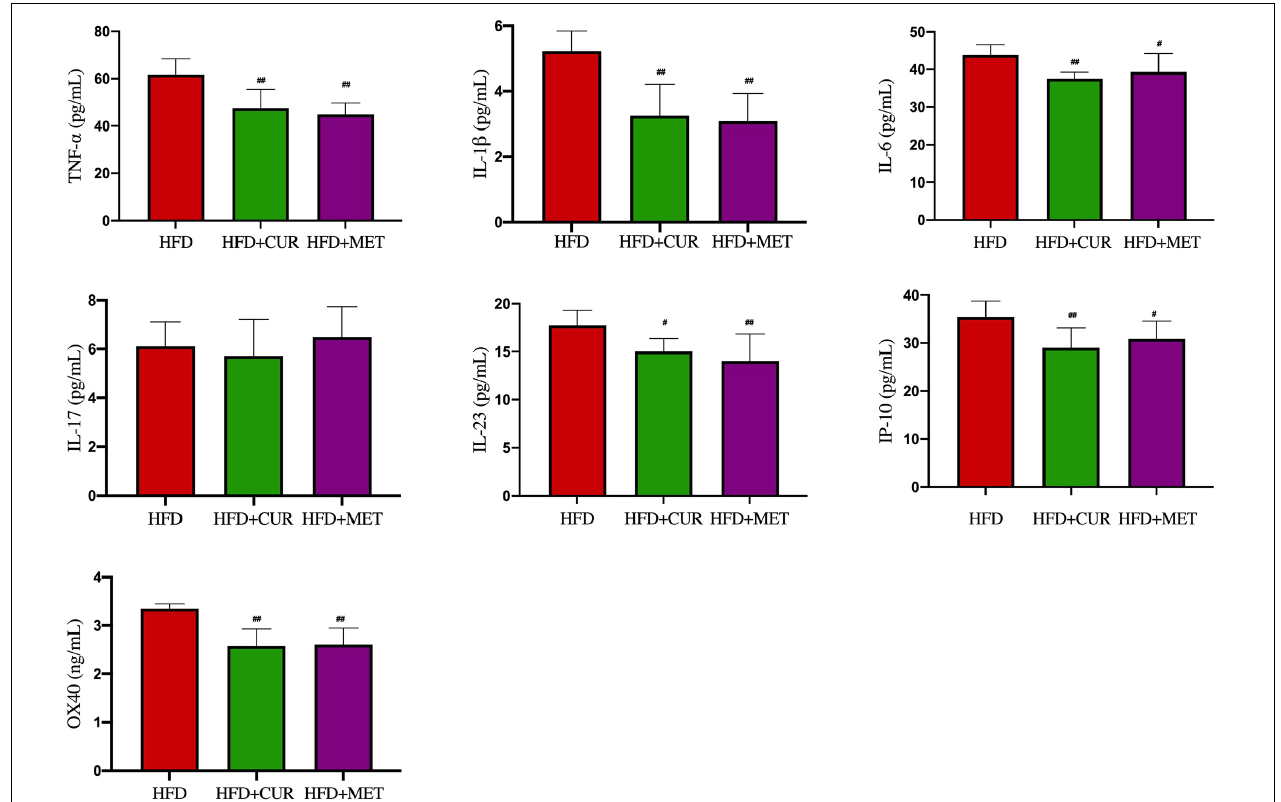
FIGURE 3 | Influence of CUR and MET on the serum inflammation factors. Seven rats per group ( n = 7). Values were presented as the means ± SD for each group. # p < 0.05, ## p < 0.01 compared with the HFD